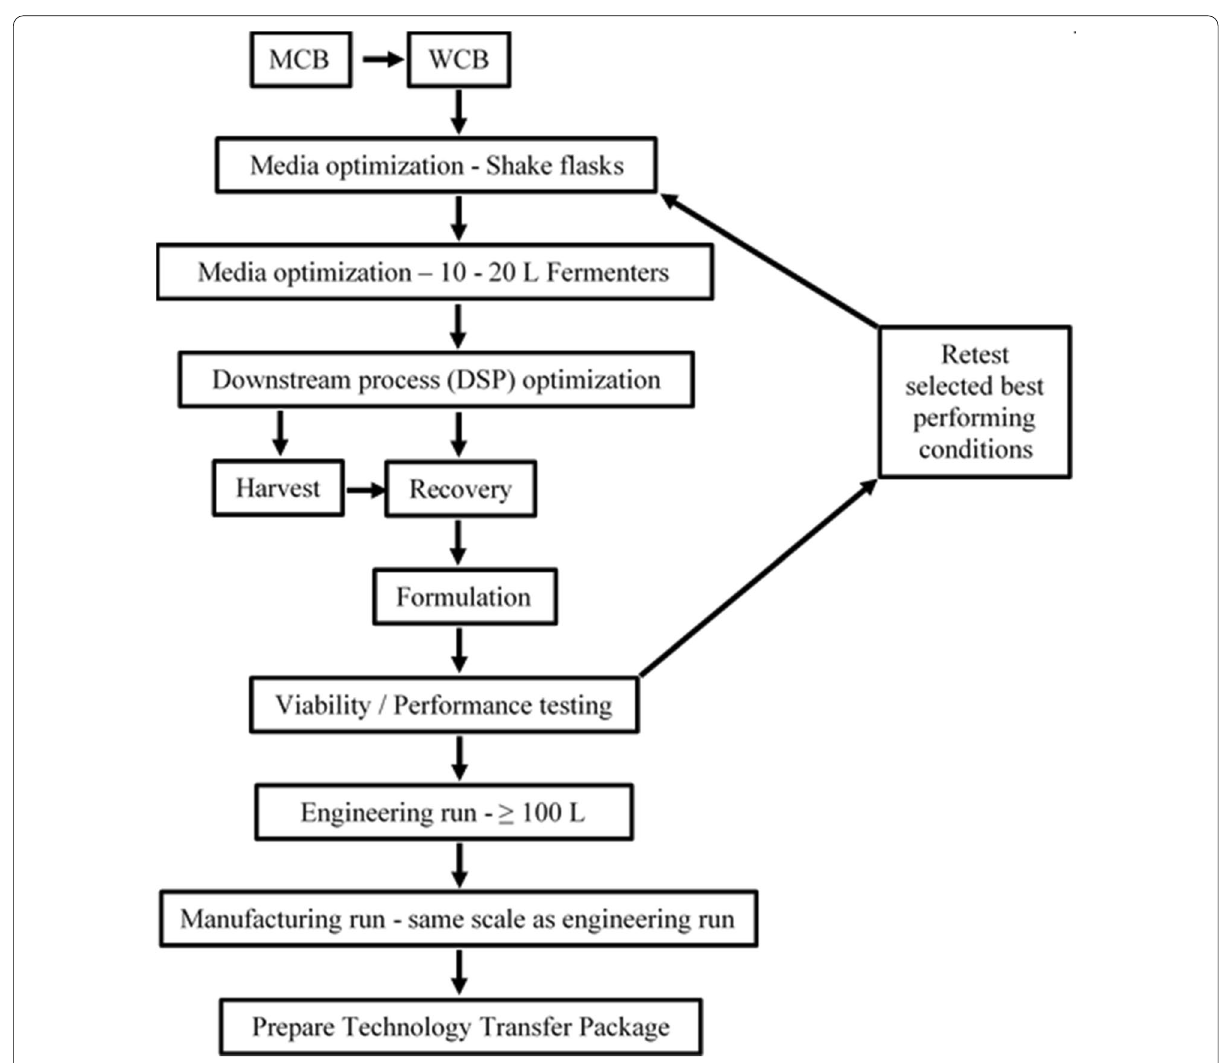
Fig. 1 A generalized schematic for fermentation scale-up